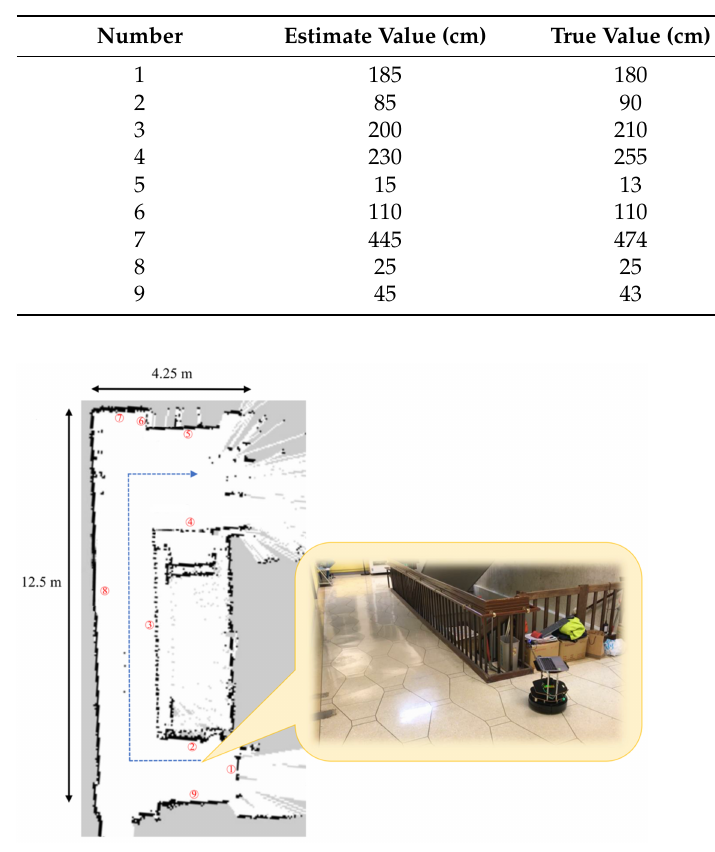
Table 13. Mapping errors of first environment.